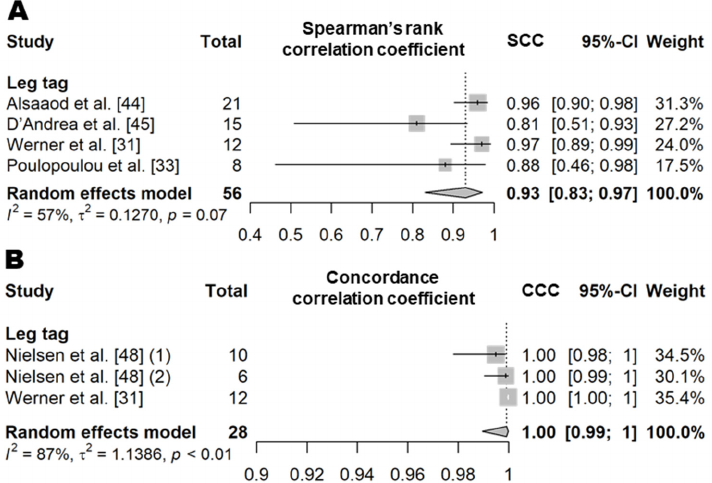
Figure 7. Forest plot of the correlation coefficient of standing time between wearable sensors and visual observation. ( A , B ) show Spearman’s correlation coefficient and concordance correlation coefficient, respectively. Numbers in parentheses indicate individual studies applying different evaluation conditions within the same article. ‘Total’ means the sample size of each study and ‘Weight’ means the weight for the mean based on the sample size.